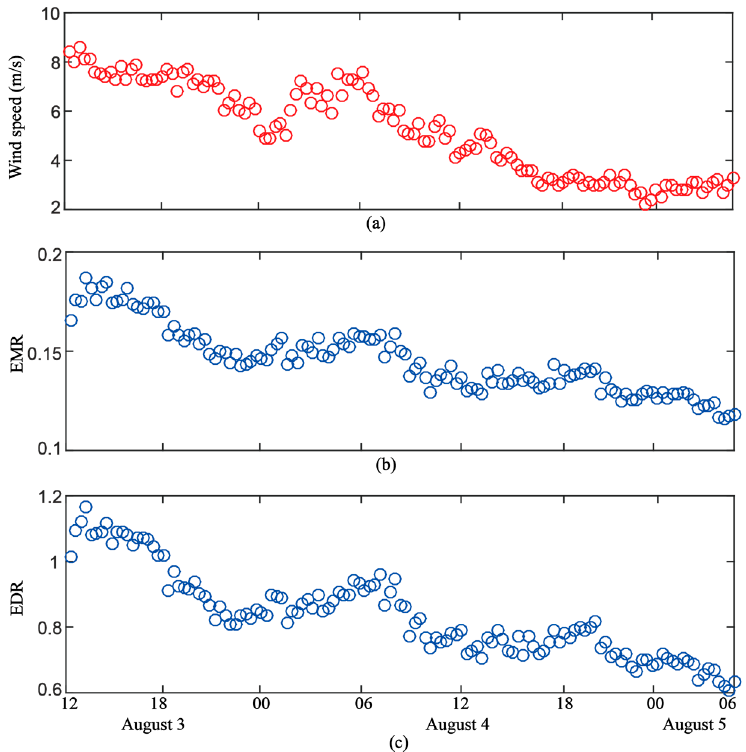
Figure 6. Comparison between in situ wind speed measurement and observables in the gentle wind scenario. ( a ) In situ wind speed. ( b ) EMR. ( c ) EDR. With Threshold 2 = 0.3, both EMR and EDR are computed from the normalized power waveform.